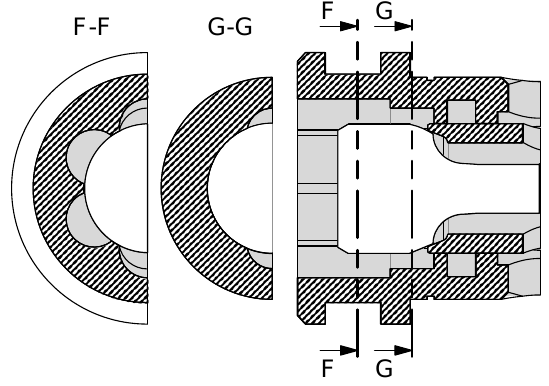
Figure 2: Valve cut-out illustrating the lack of axisym- metry in the restricted flow